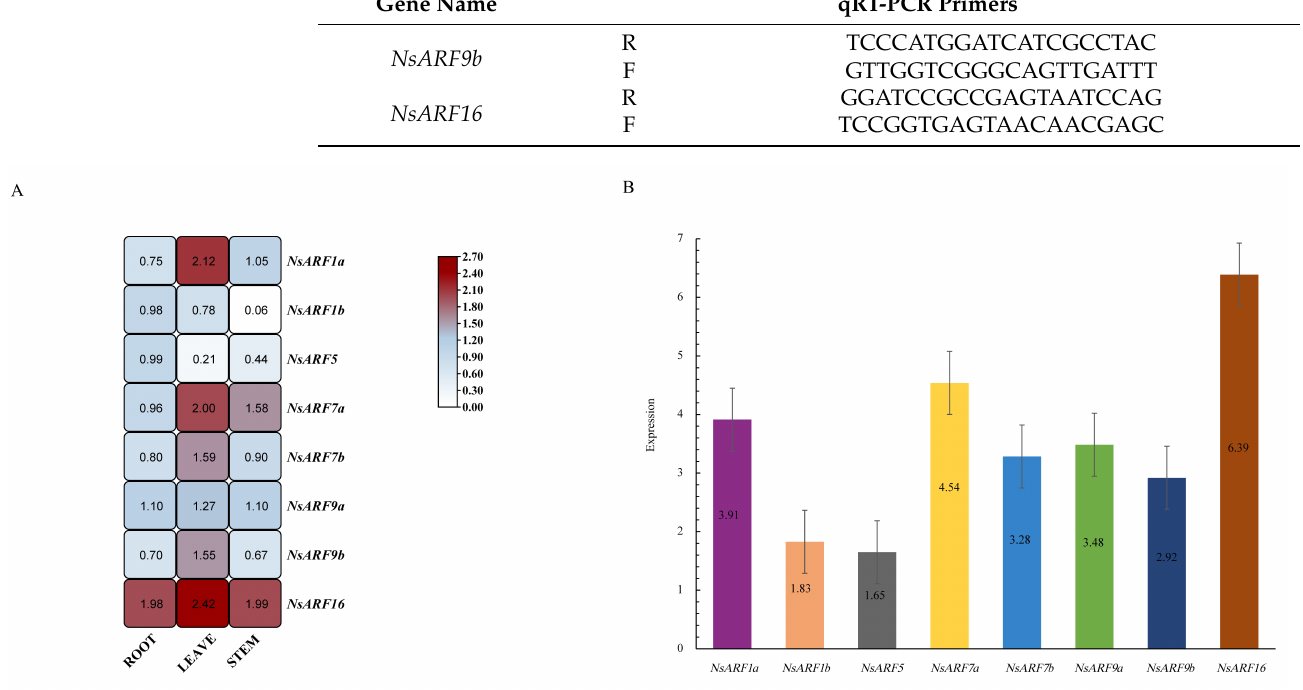
Figure 5. ( A ): Expression analysis of NsARF genes in different tissues of Nitraria sibirica . ( B ): Expres- sion analysis of NsARF genes in one total plant of Nitraria sibirica